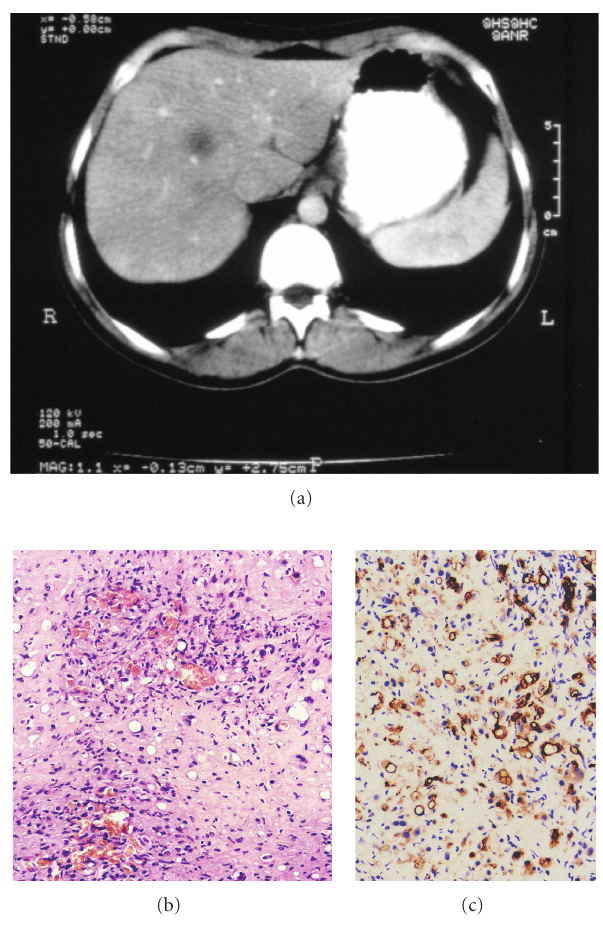
Figure 2: (a) Abdominal computed tomography showing an hy- podense lesion in the liver. (b) Tumor composed of fibrous stroma with myxohyaline areas containing epithelioid cells with intracellu- lar vacuoles (H&E, x20). (c) Tumor cells are immunostained with antibody to